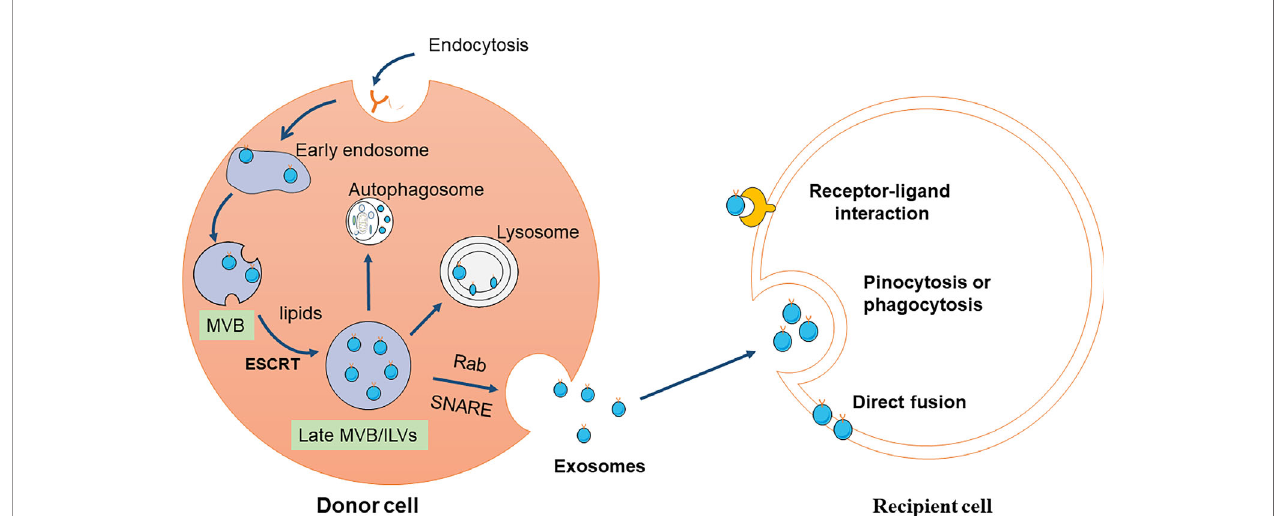
FIGURE 1 | Schematic diagram of exosomes production and reception. Exosomes are originated from the MVBs, referring to double invagination of the plasma membrane. Early sorting endosomes (ESEs) are formed by plasma membrane invagination, which can be fused with the endoplasmic reticulum (ER) and trans-Golgi network (TGN) to produce late sorting endosomes (LSEs). The second invagination in LSE leads to the formation of intraluminal vesicles (ILV). MVBs are formed from LSEs with several ILVs under two mechanisms, ESCRT-dependent and ESCRT-independent pathway. Some MVBs can be degraded by fusion with autophagy or lysosome, while others can be transported to the plasma membrane and released to the extracellular environment. Exosomes are composed of various proteins, lipids, DNA, and RNA. The released exosomes are mainly uptaken by recipient cells through three pathways, including endocytosis, direct fusion, and receptor-ligand